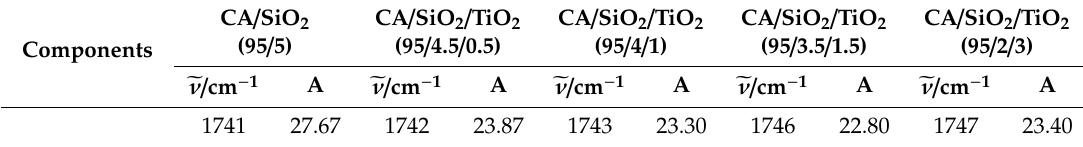
Table 4. Areas and wavenumbers of the carbonyl group located in the 1690–1800 cm − 1 region for the series 1 membranes.